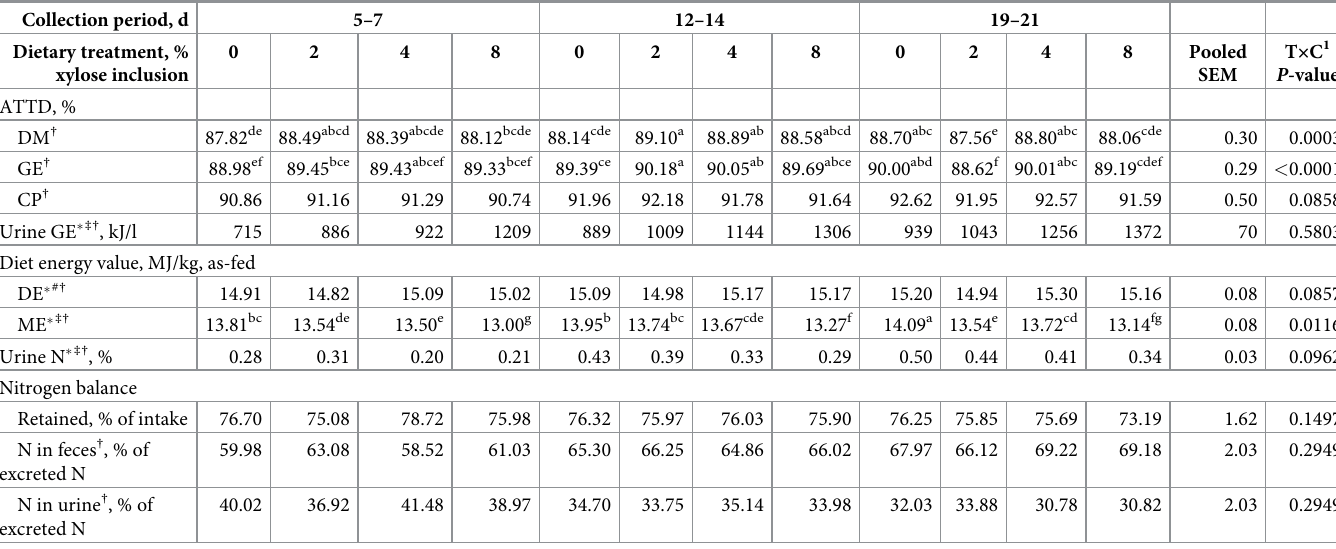
Table 5. Effect of dietary xylose concentration and collection period on diet digestibility and energy value and on nitrogen